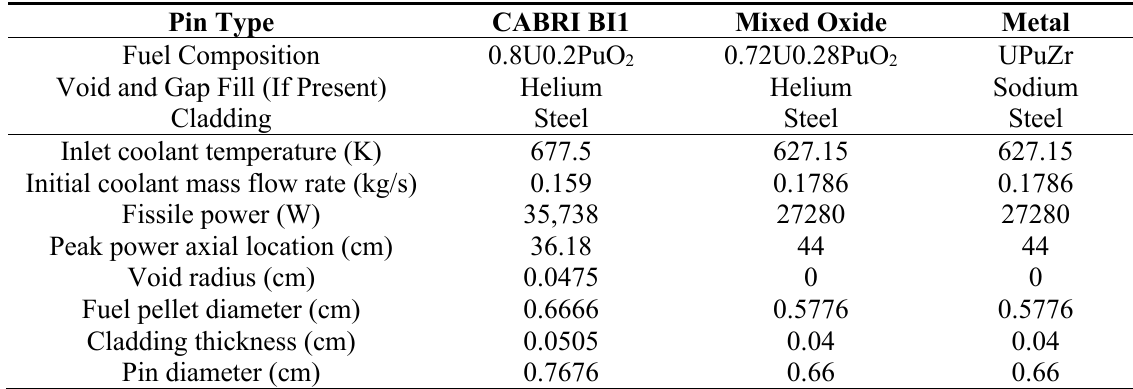
Table I . Design parameters for the CABRI MOX pin, standard MOX pin, and standard metal